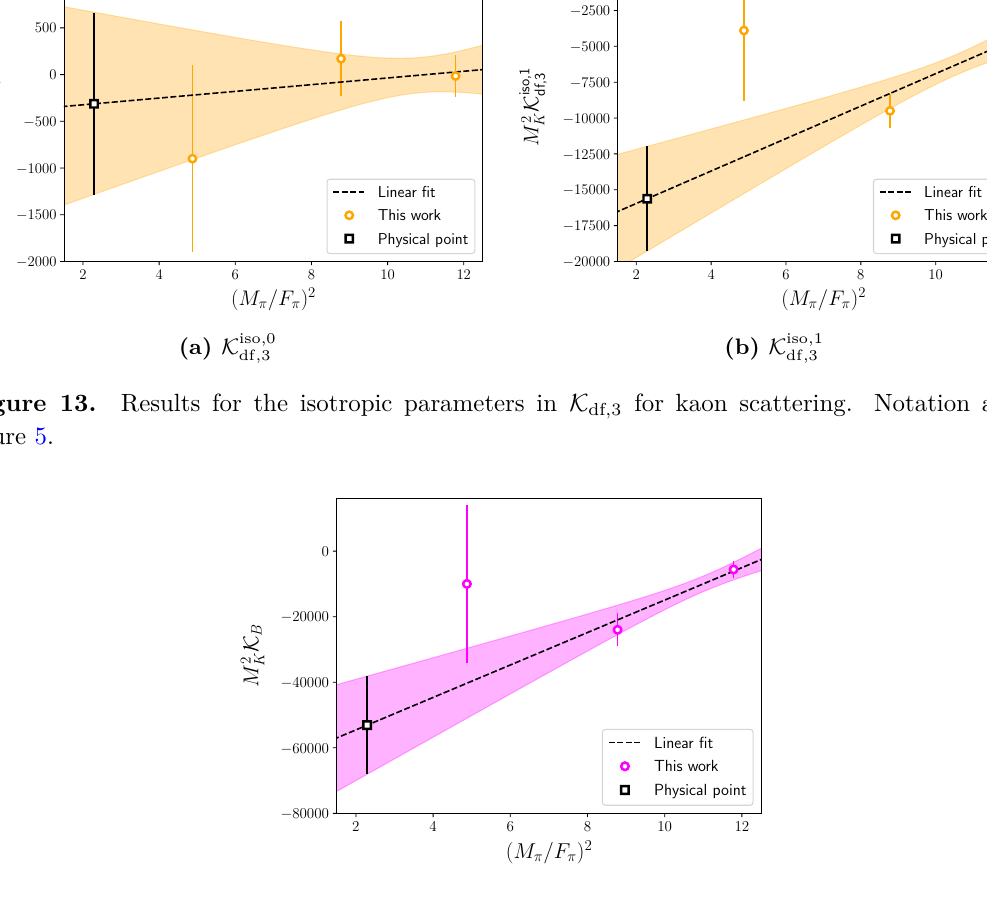
Figure 14. Results for K B for kaon scattering. Notation as in figure